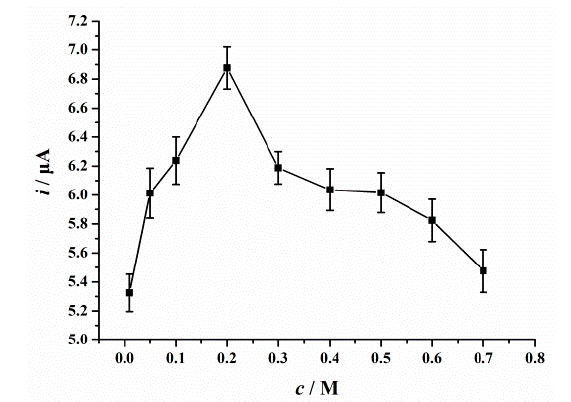
Figure 7. The dependence relationship of the peak current of 10 µM rutin and H 2 SO 4 concentration by SDLSV, error bars represent SD, n = 3. Accumulation potential: − 0.3 V, accumulation time: 30 s, scan rate of 0.1 V/s. 3.6. Optimization of Parameters 3.6.1. Electrochemical Reduction Conditions It is well known that pure GR sometimes fails to demonstrate perfect performance because oxygen-contaminated functional groups (OxFG) often play a leading role of catalytic active centers in electrochemical reactions as reported [44,45]. The potentiostatic reduction method is easy to control. By changing the potential and time of reduction, a certain number of OxFG can remain [44].